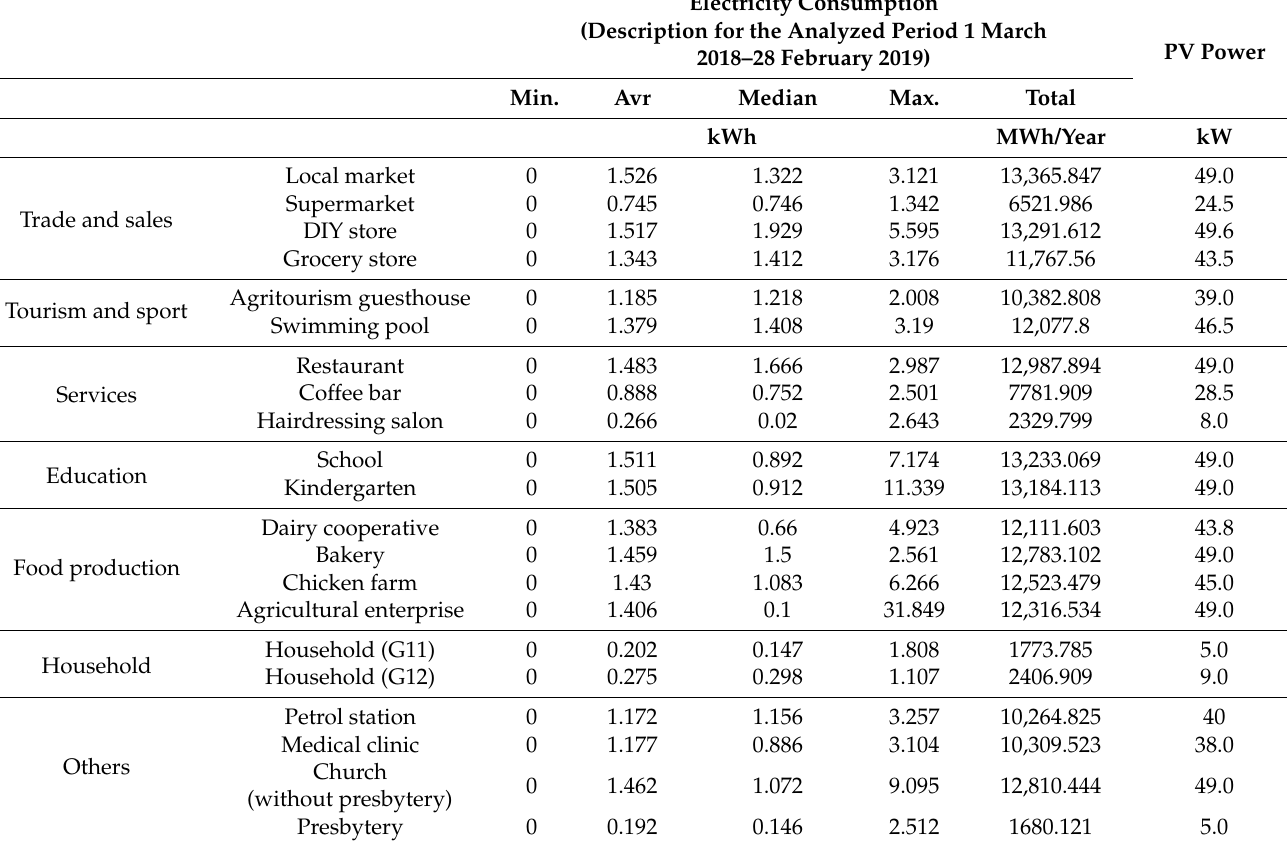
Table 2. Summary of statistics for prosumers included in the sample from the population